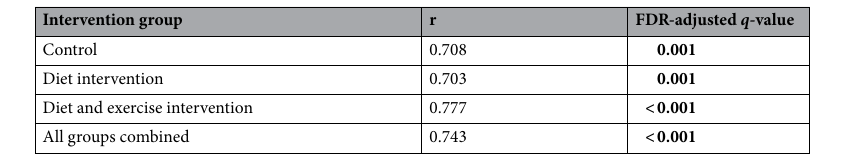
Table 9. Pearson’s correlations between measured plasma LCN2 concentrations pre- and post-interventions per group. Data are from two-tailed Pearson’s correlations, with q -values under 0.05 bolded. FDR, False Discovery Rate.